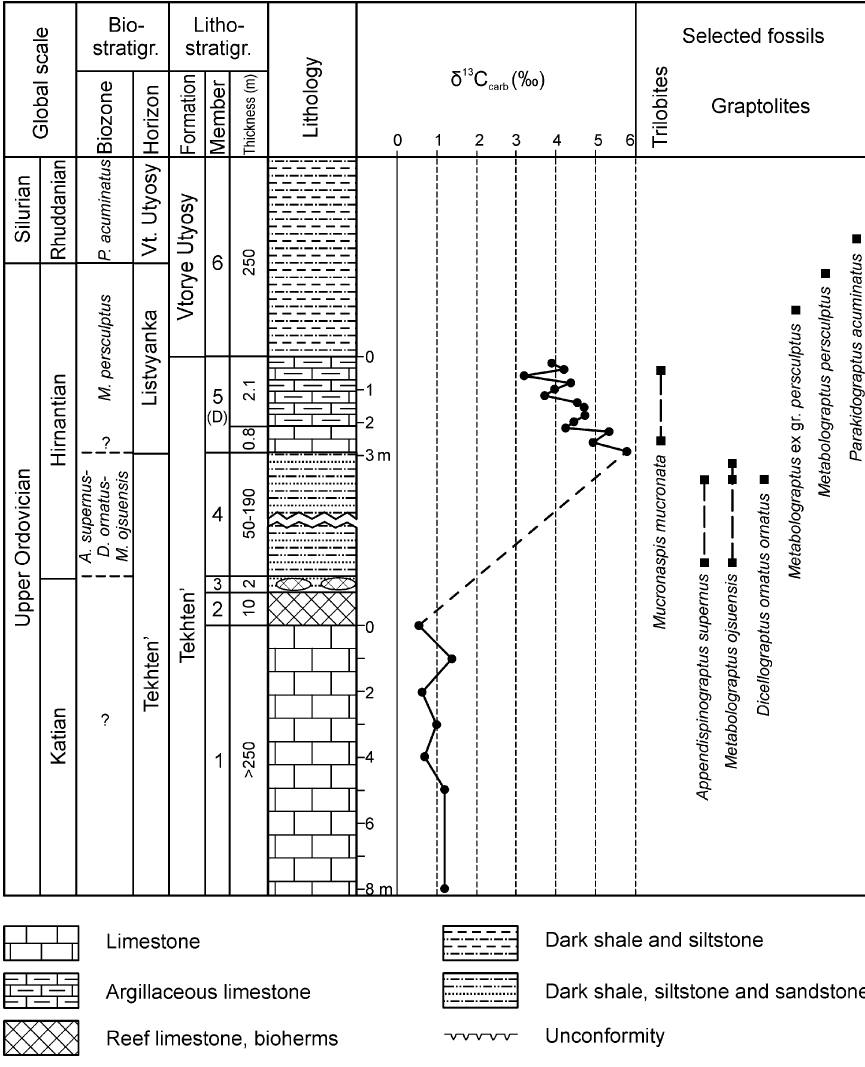
Fig. 3. Stratigraphy, selected fossils (after Sennikov et al. 2014) and carbon isotope data of the Burovlyanka section. Note that thicknesses of the stratigraphic units are not to scale, except for the sampled intervals (members 1 and 5). D, Dalmanitina Member (Member